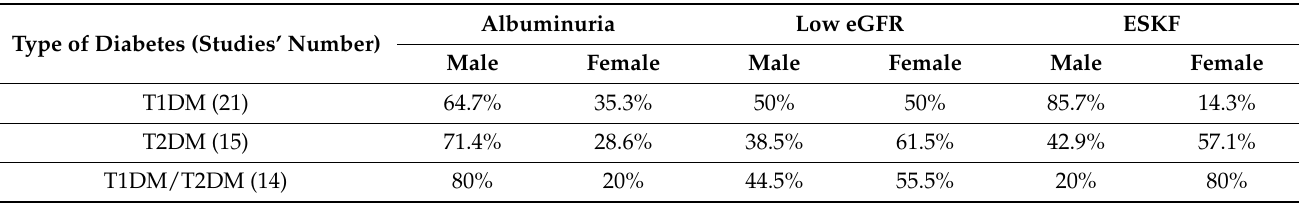
Table 1. Summary of analyses by Giandalia et al. [28] and Piani et al. [26] of 49 studies showing sex dif- ferences in DKD. Multiple comparisons between albuminuria, eGFR, and ESKF are possible. In each case, the percentage sex distributions indicate the higher risk for sex in the phenotype